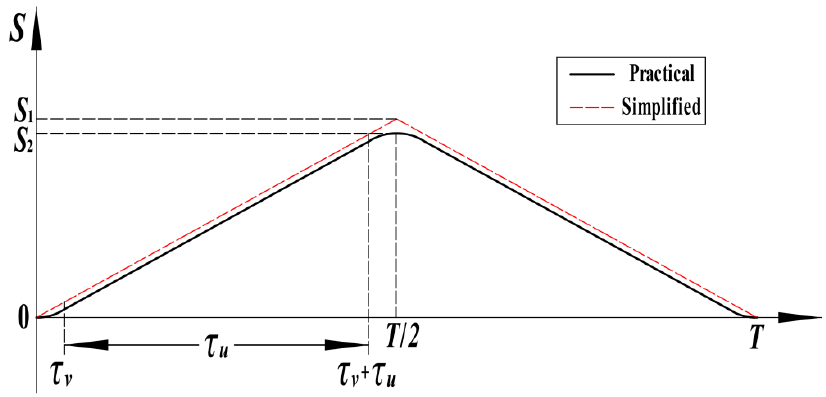
Figure 1. Displacement curves of practical and simplified motion.